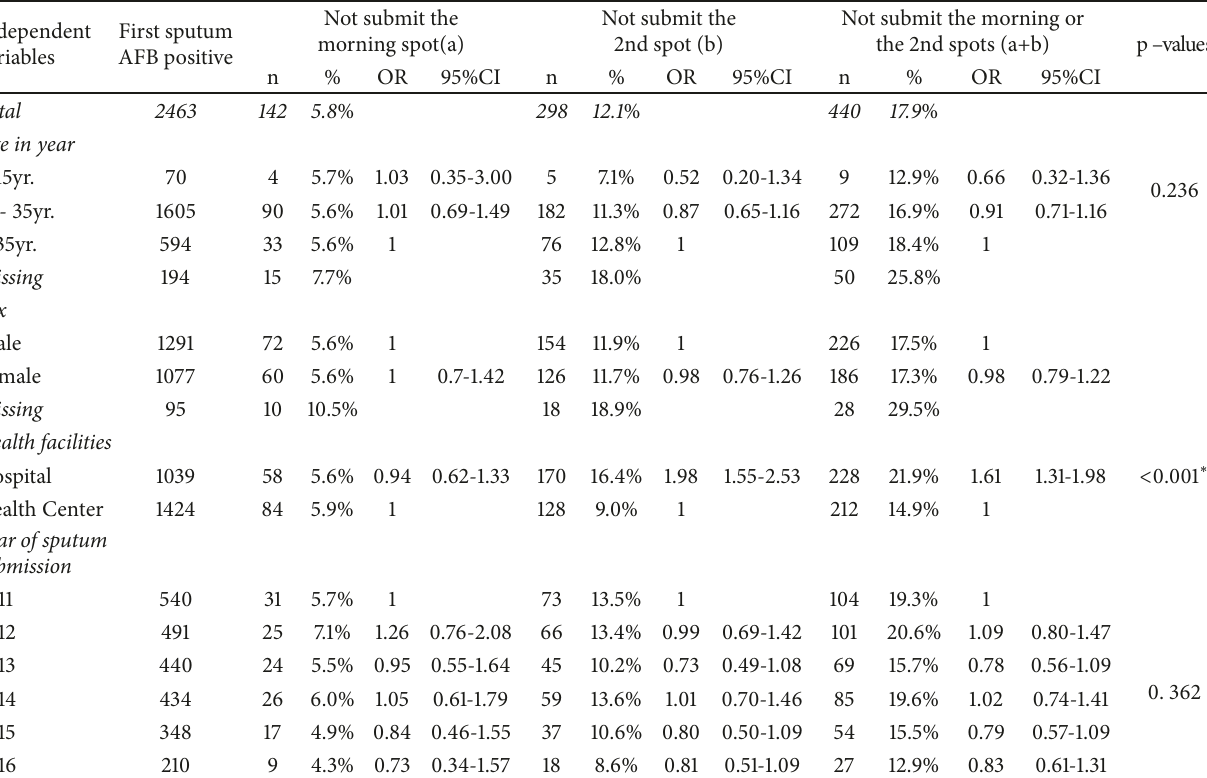
Table 2: Mono-variate analysis the association between dropout rate and age, sex, health facility and period of registration of sputum smear positive PTB at public health facilities in Addis Ababa, Ethiopia, from 2011-2016.